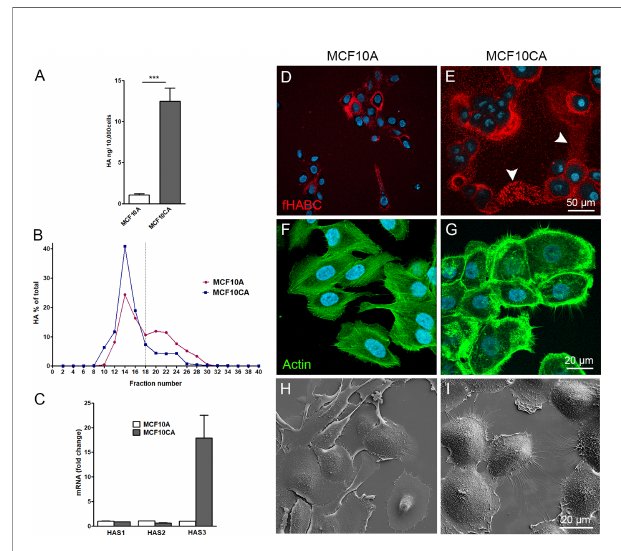
FIGURE 1 | MCF10CA cells synthesize more hyaluronan and express higher levels of HAS3 than MCF10A cells. Hyaluronan secretion levels by MCF10A and MCF10CA cell lines analyzed by hyaluronan assay (A) and analysis of relative molecular weight distribution of produced hyaluronan (B) . Relative expression levels of HAS isoenzymes (C) . Confocal images of live MCF10A (D) and MCF10CA (E) cells stained with fHABC to detect pericellular hyaluronan (arrowheads in E indicate HA-rich trails) and fi xed cell stained with phalloidin to show actin cytoskeleton of MCF10A (F) and MCF10CA (G) . Scanning electron microscopic images of MCF10A (H) and MCF10CA (I) . Blue = nucleiin (D – G) . The data represent means ± SE of 6 independent experiments in (A) ± SE of 3 independent experimentsin (B, C) ***p < 0.001, Mann – Whitney